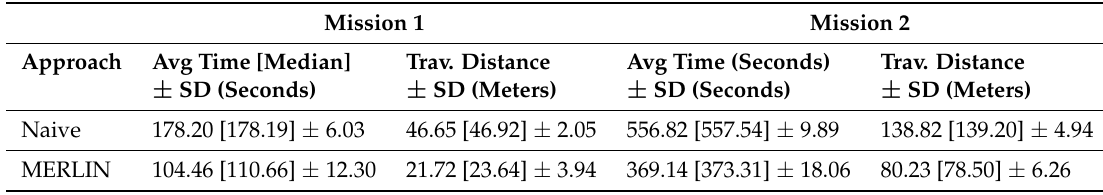
Table 1. Experimental results for each mission.